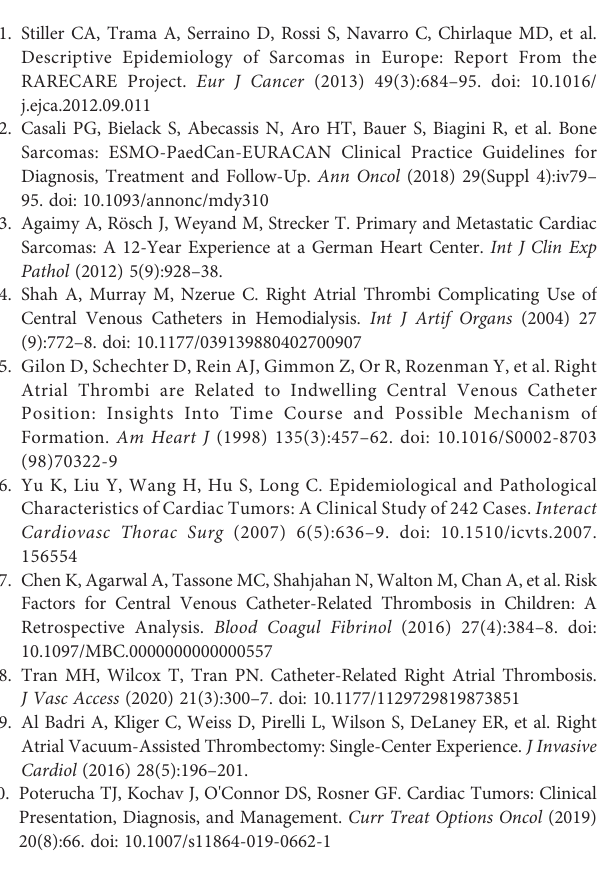
Supplementary Figure S2 | The radiographic data and operative fi eld of patient 2. (A) On chest X-ray, catheter tip was located in right atrium (blue arrow). (B) The